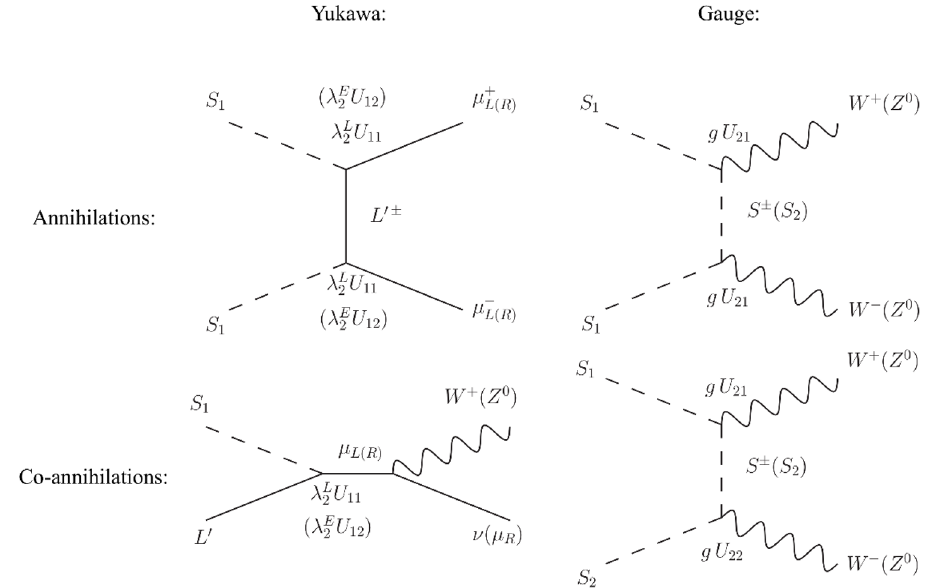
Figure 8 . (Co-)annihilation processes relevant for S 1